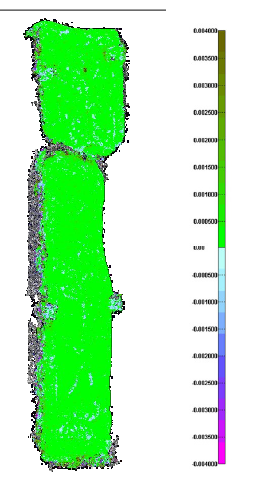
Figure 13 Comparison between two model of the same object setting as reference the high quality target model and as data the medium